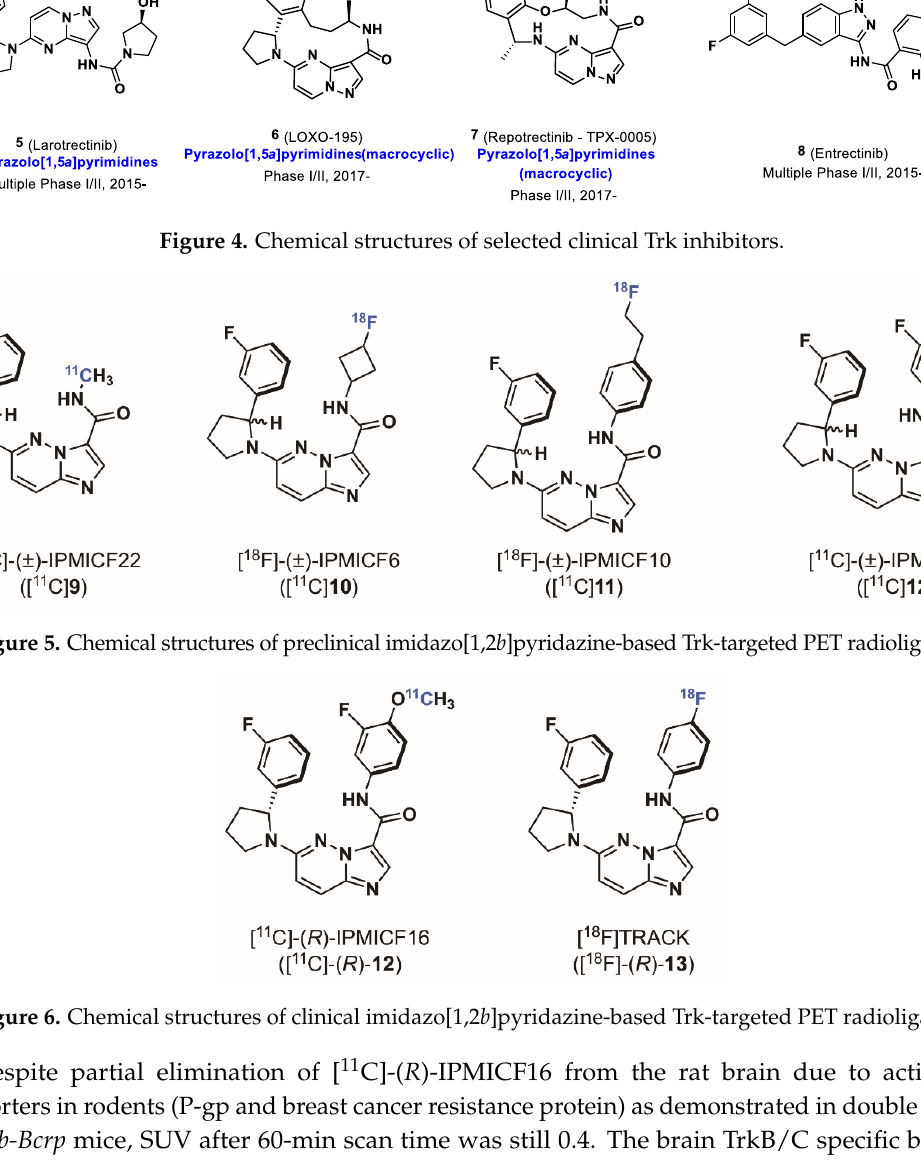
Figure 7. Upper row: PET/T1MP-RAGE MRT in vivo overlay images of [ 11 C]-(R)-12 in a human subject with high SUVs in TrkB/C rich compartments such as thalamus, followed by cerebellum and cortical grey matter and low uptake in Trk devoid white matter areas; Bottom row: In vivo PET images of [ 18 F]-(R)-13 (high A m of 245 GBq/µmol) in rhesus monkey brain matching the expected TrkB/C distribution. 3. Conclusion The analysis, investigation and quantification of Trk receptors in neurodegenerative diseases and cancer is currently limited to ex vivo post-mortem analysis or invasive methods. While these kinases constitute important molecular targets which can be visualized using non-invasive PET imaging, Trk PET imaging is still in its infancy. Whether prototypical radioligands such as [ 11 C]-( R )- IPMICF16 and [ 18 F]TRACK, which display moderate brain uptake in humans, will be suitable for clinical neuroimaging and can provide reliable CNS TrkB/C measurements or adequately detect reductions in receptor density remain to be established. While tracers with higher brain penetration, volume of distribution ( V T ) values or binding potentials are desirable for temporally and spatially assessing Trk expression in conditions such as AD, the current tracers could certainly be beneficial in cases where Trk is overexpressed such as in numerous human cancers, both in the periphery and CNS. Further research is currently aimed at identifying structural determinants improving overall brain uptake of current type I and II tracers, including cyclic derivatives such as LOXO 195 and derivatives thereof.